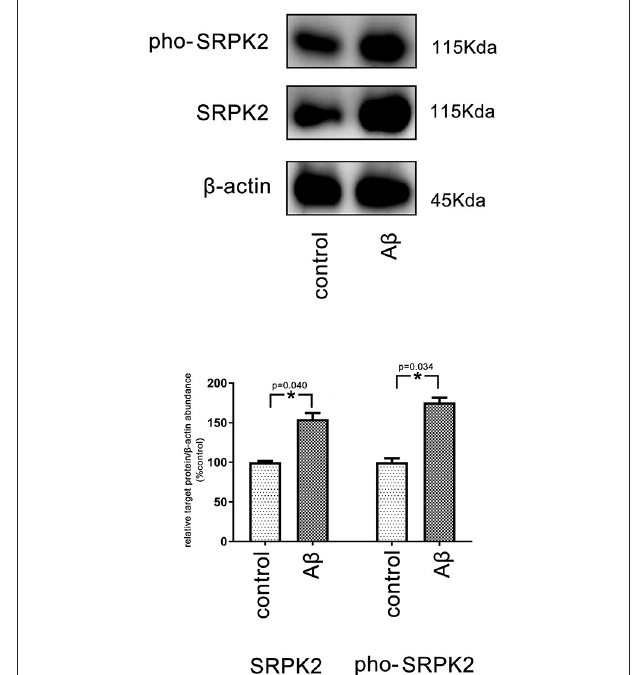
FIGURE 5 | The expression level of SRPK2 in the BV2 cells after treatment with A β . The BV2 cells were treated with A β for 24h, while the cells treated with DMSO were considered as controls. The cells were collected and the expression of SRPK2 and phosphated SRPK2 levels were examined by the western plot. The results showed that the expression of both the SRPK2 level and the phosphated SRPK2 level was significantly increased compared to the controls. All the experiments were performed independently in triplicate. The data were presented as the mean ± SEM. * p < 0.05, by the Student’s t -test. pho-SRPK2, phosphated